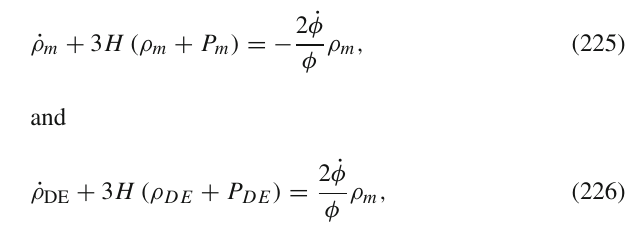
curves correspond to the best fit and lower/higher 2 σ extreme values of the parameter δ in Table 2. The red solid line corresponds to the (cid:2) CDM model, and the error bars represent the observational